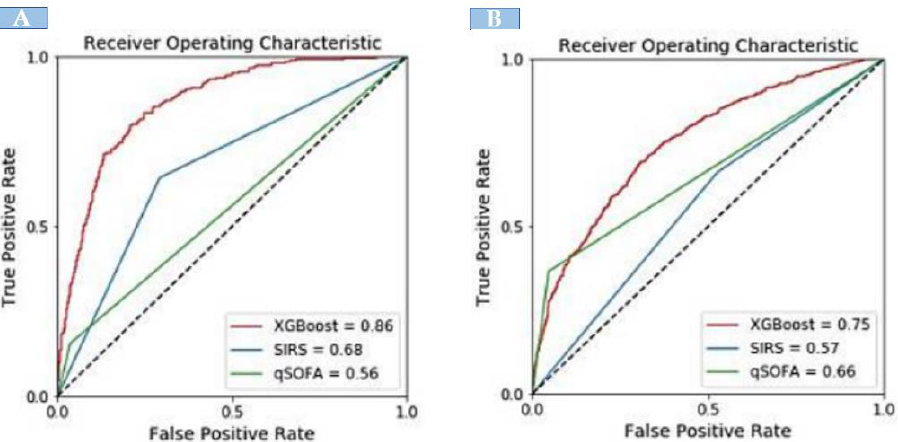
Figure 2. The area under the receiver operating curve comparison of XGBoost model with SIRS and qSOFA; ( A ) internal validation and ( B ) external validation.